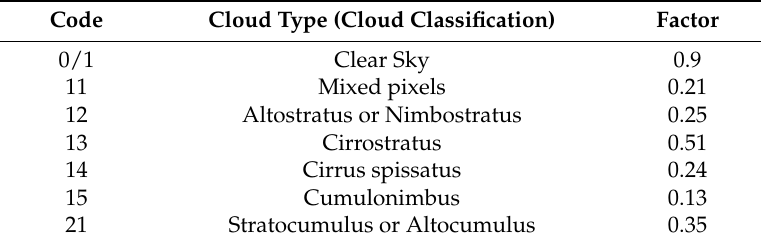
Table 3. FY-2D cloud-type factor for the Heihe River Basin. Code Cloud Type (Cloud Classification) Factor Clear